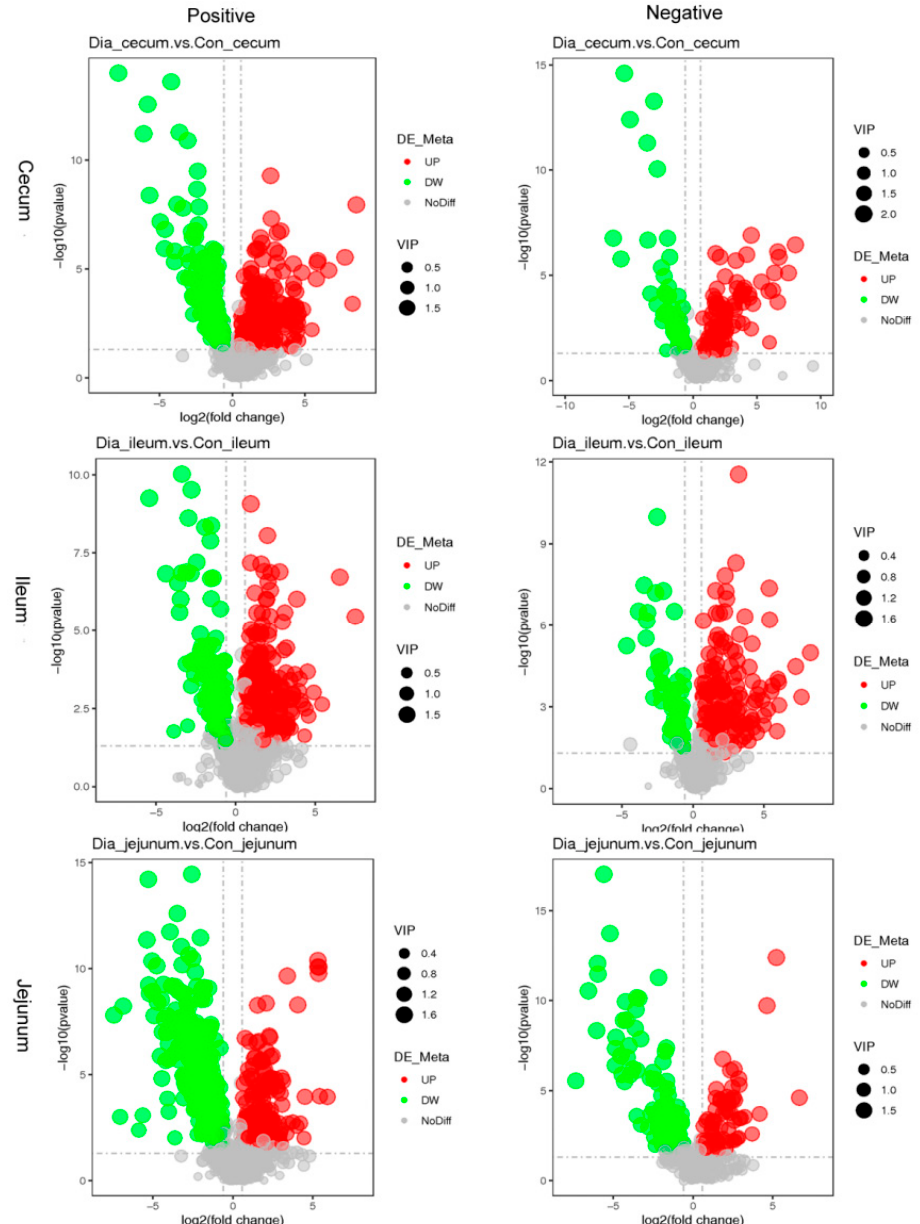
Figure 3. Volcano map of the difference in metabolites of Hyplus rabbits’ jejunum, ileum, and cecum tissue samples in the positive and negative ion modes. Green represents the downregulated metabolites, red represents the upregulated metabolites, respectively, different between groups, and gray represents the metabolites without significant changes. The abscissa indicated the change of differential metabolites between the Dia group and the Con group. The ordinate represents the significant level of differential metabolites between groups. Note: positive: cationic mode; negative: anion mode.